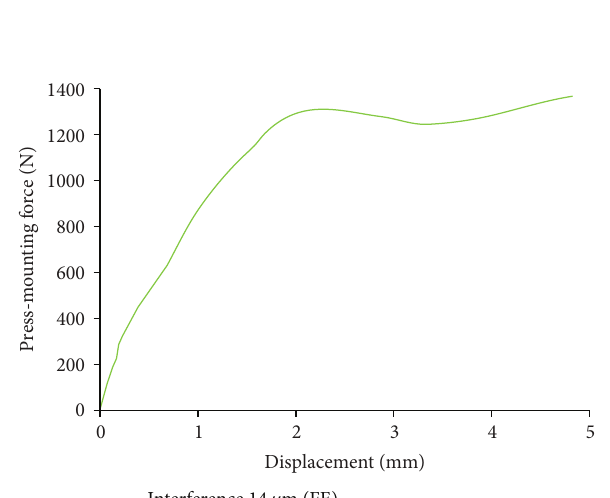
Figure 13: The unqualified press-fit curve